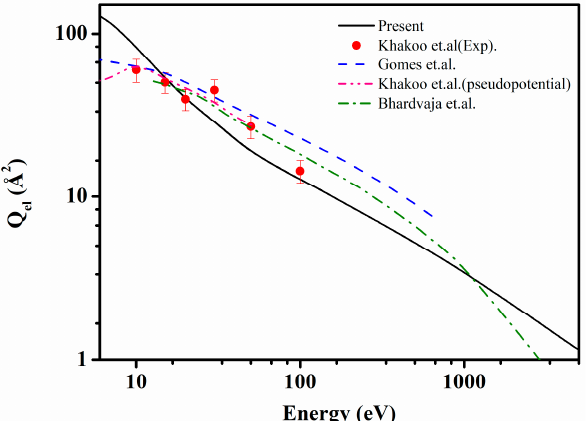
Figure 1. Elastic cross-section of butan-1-ol: solid black line represents present result, solid circles (red) depict experimental data from Khakoo et al., dashed (blue) line is ICS from Gomes et al., dash-dot line (green) is from Bhardvaja et al. and pink dash-dot-dot line represents pseudopotential calculations from Khakoo et al.